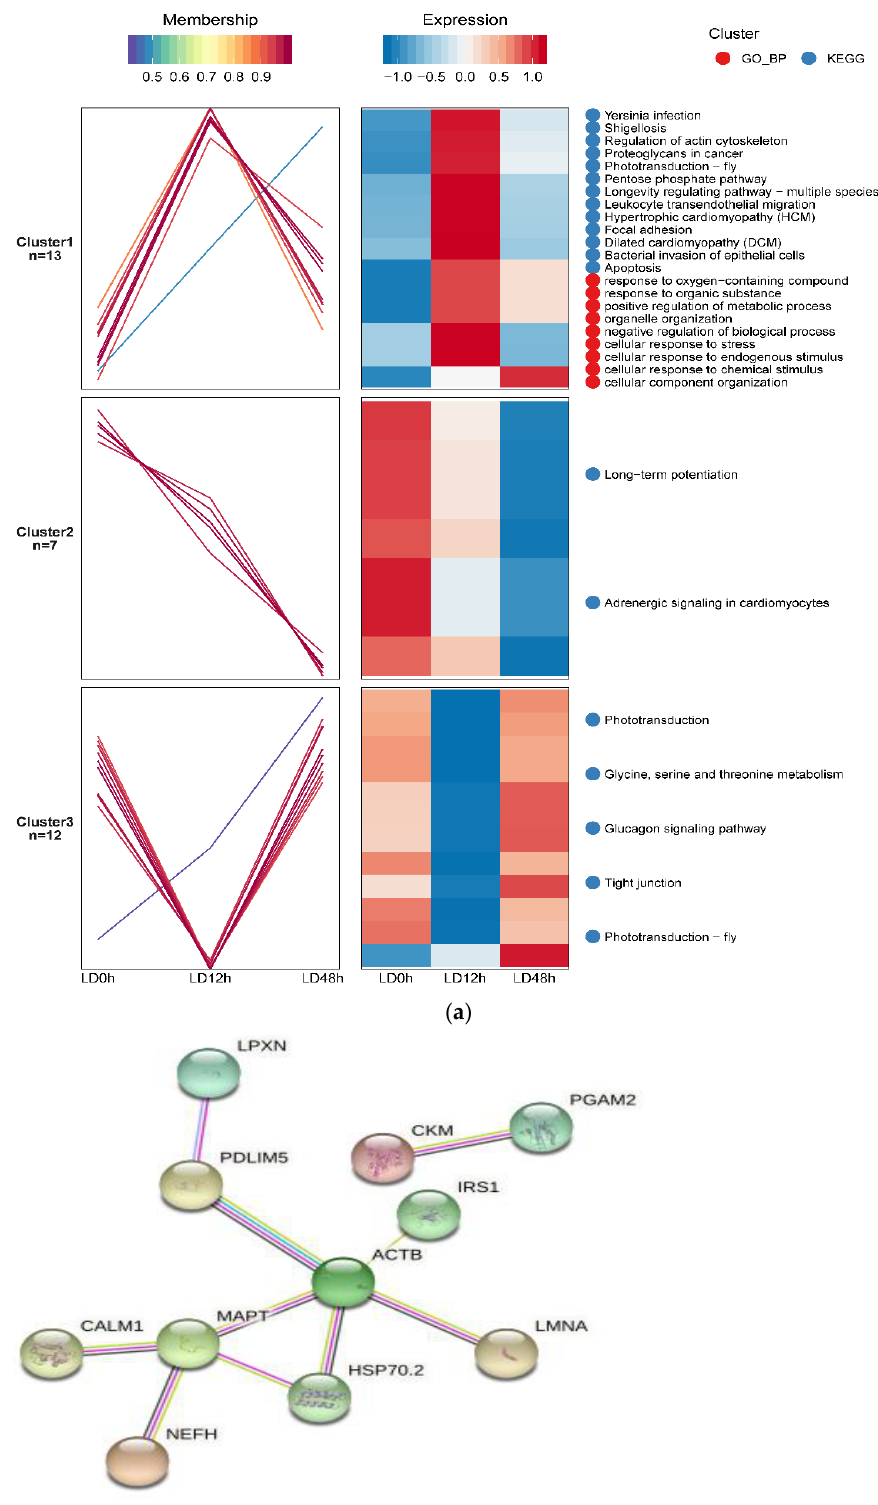
Figure 4. ( a ) Mfuzz analysis of differentially expressed protein profiles in postmortem pork muscle. The shade of red and blue represents high expression and low expression, respectively. ( b ) Protein– protein interaction (PPI) networks of differentially expressed proteins in postmortem pork muscle. The interaction network only presented proteins with connections.